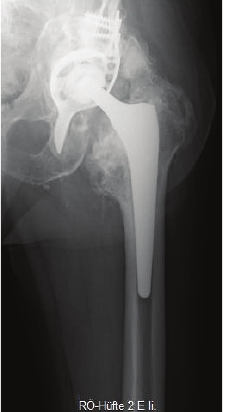
Figure 7: Follow-up X-ray of left hip a.p. two years and eight months postoperatively.